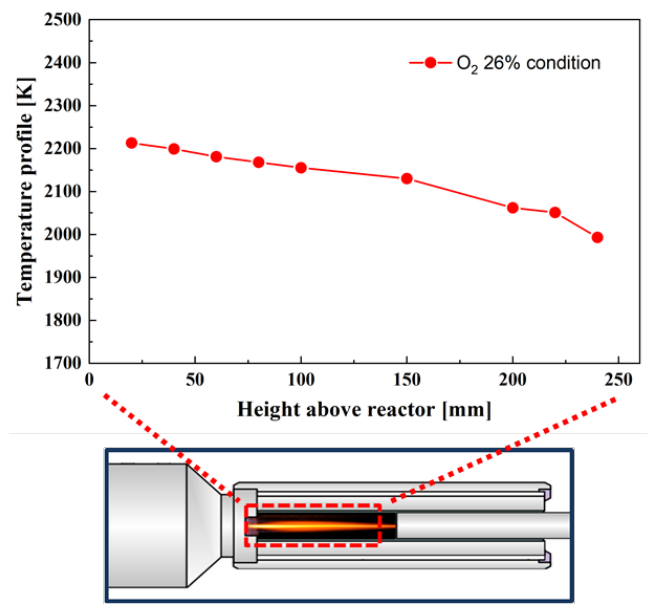
Figure 4. Gas temperature profile at the LFR center line.